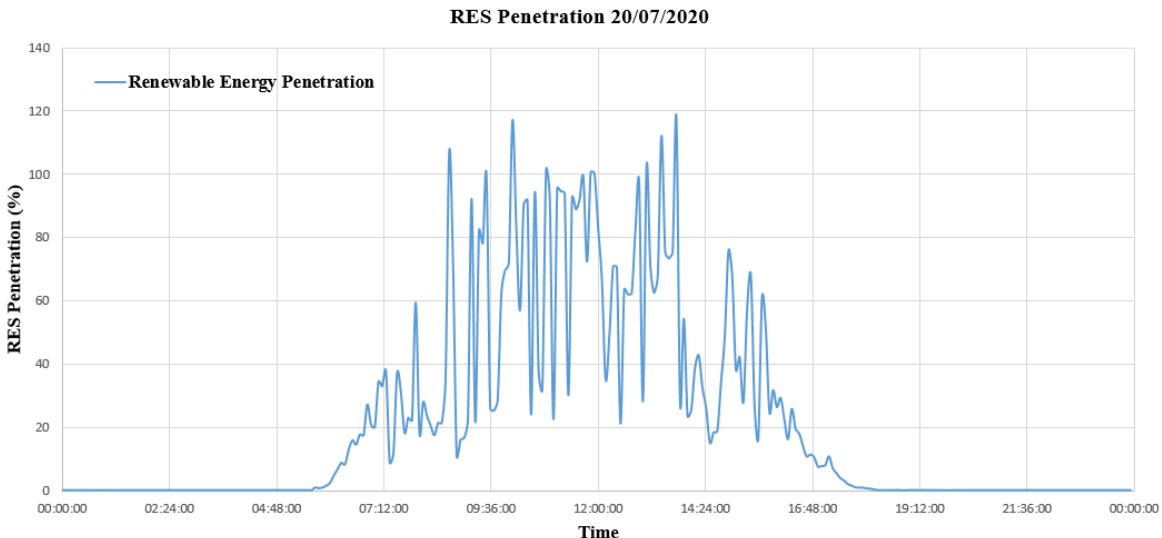
Figure 28. PV penetration of the MCAST micro-grid during a typical weekday.